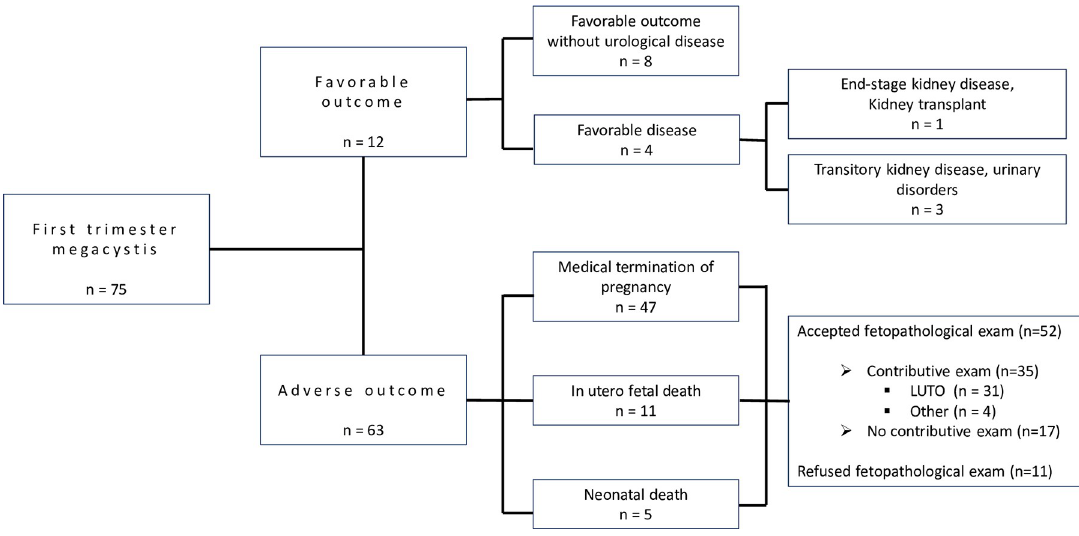
Fig 1. Flow chart.